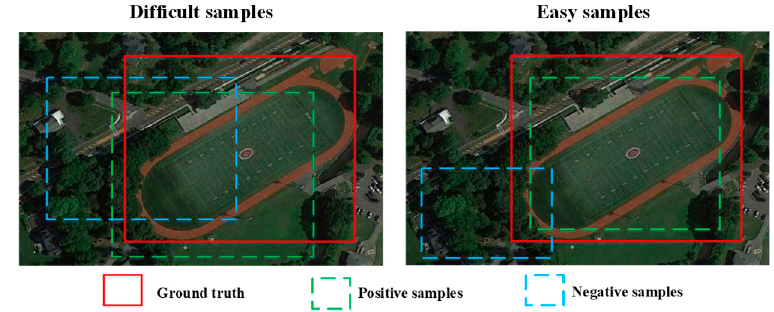
Figure 7. The sample types in the training of the